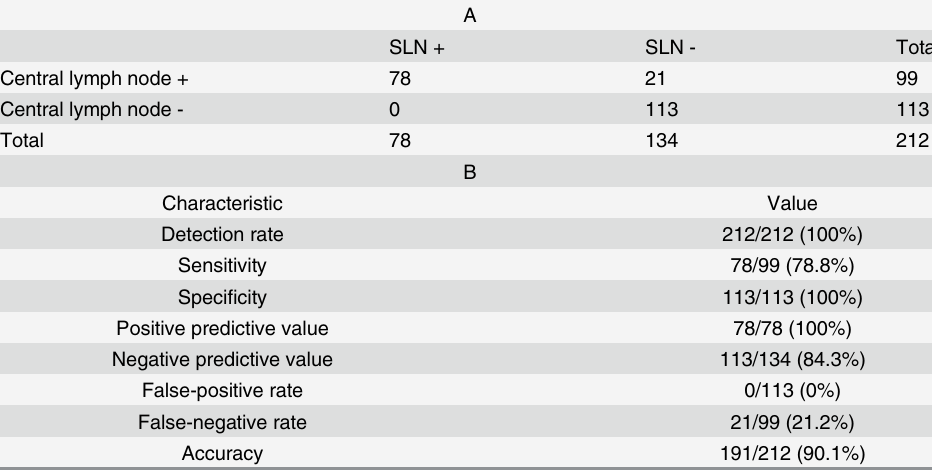
Table 2. Results of SLNB using CNS in the central